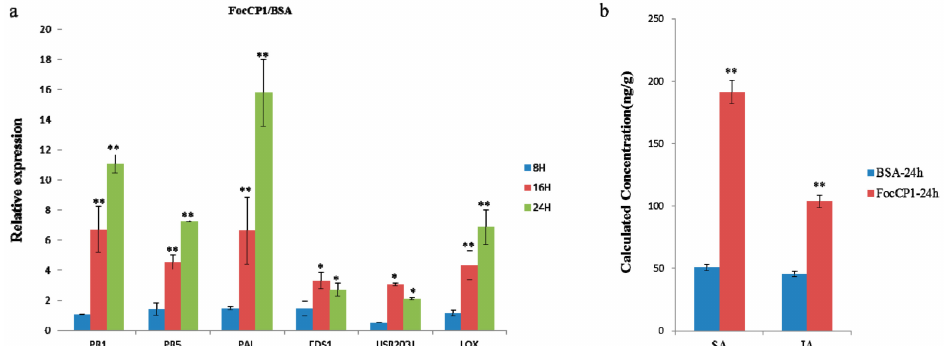
Figure 4. FocCP1 exhibited elicitor function in tobacco. ( a ) The expression of pathogenesis-related PR ( PR-1, PR-5 ) genes was induction started after 16 h treatment and obviously induction started after 24 h treatment. The marker gene ( PAL ) of the salicylic acid (SA)-dependent defense pathway was significantly induction started by FocCP1 after 24 h treatment, but strong induction was not observed for EDS1 . The HR marker gene ( HSR203J ) was induced by FocCP1 after 16 h treatment. The same expression pattern was found for the jasmonic acid (JA) / ethylene (Et) pathway gene ( LOX ) after 16 h treatment. All related genes were not significantly up-regulated after 8 h induction. ( b ) The contents of SA and JA were increased in tobacco leaves treated by FocCP1 after 24 h induction. Essentially identical results were obtained in three independent experiments. Values were means ± SE. Statistical analysis of data was conducted using SAS (*, p < 0.05; **, p <